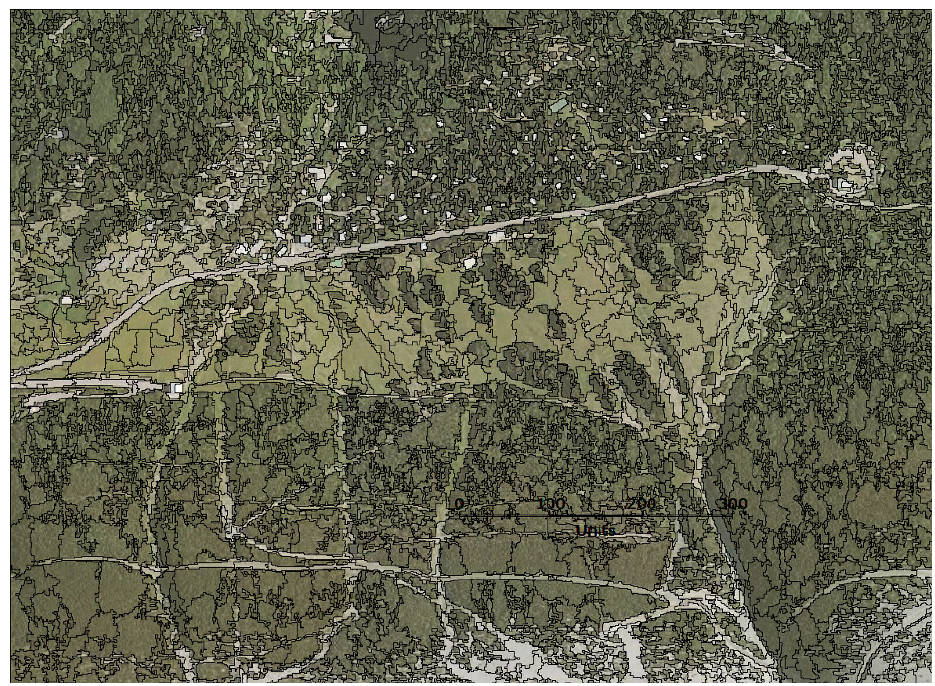
Figure 5. Segmentation obtained using Baatz and Schäpe algorithm with scale 20 (BS-20).